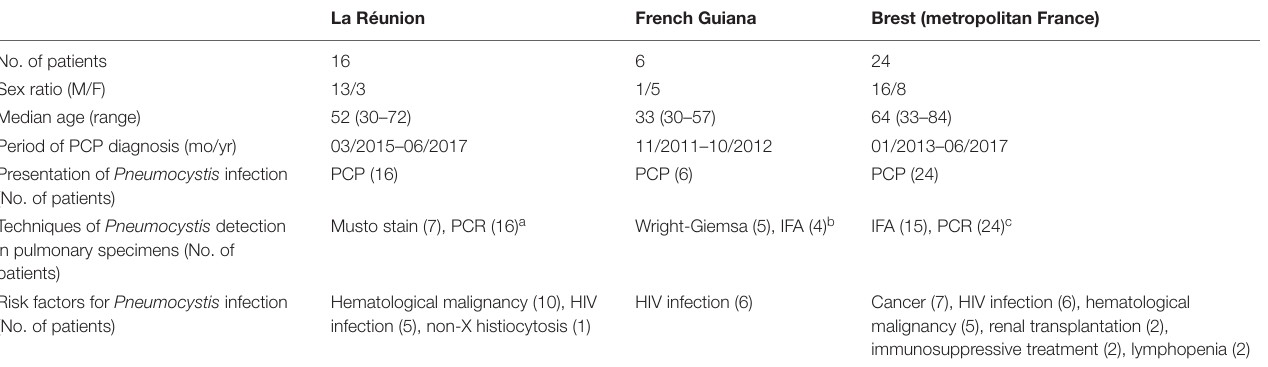
TABLE 1 | Characteristics of the three groups of patients from whom Pneumocystis jirovecii specimens were genotyped. La Réunion French Guiana Brest (metropolitan